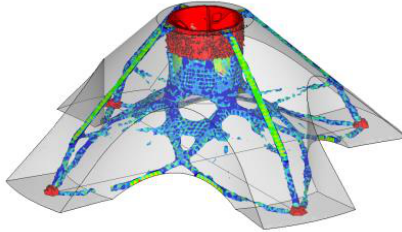
Figure 17. Iso view of design space (gray shaded region) and initial topology optimization result.